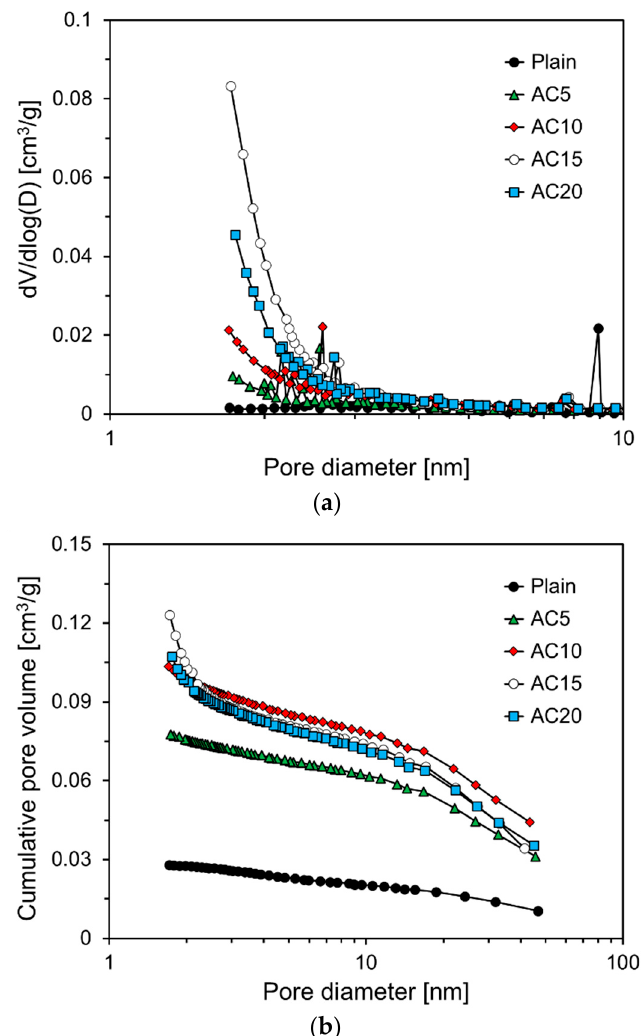
Figure 12. Pore size distributions and cumulative pore volume of specimens. ( a ) dV / log(D); ( b ) Cumulative pore volume.